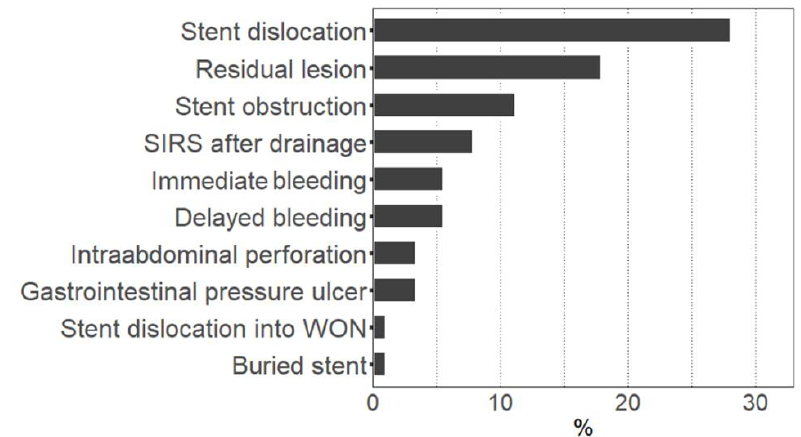
Figure 1. Rate of adverse events during endoscopic drainage therapy. Figure shows the percentage of cases with occurrence of the respective adverse event. Multiple adverse events in one case were possible. SIRS: Systemic inflammatory response syndrome. WON: Walled-off necrosis. Table 1. Baseline phenotype characteristics of cases with adverse events and uncomplicated controls. Adverse Events